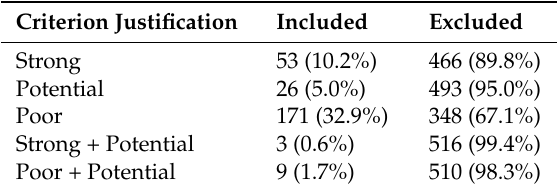
Table 5. Patient eligibility rates per